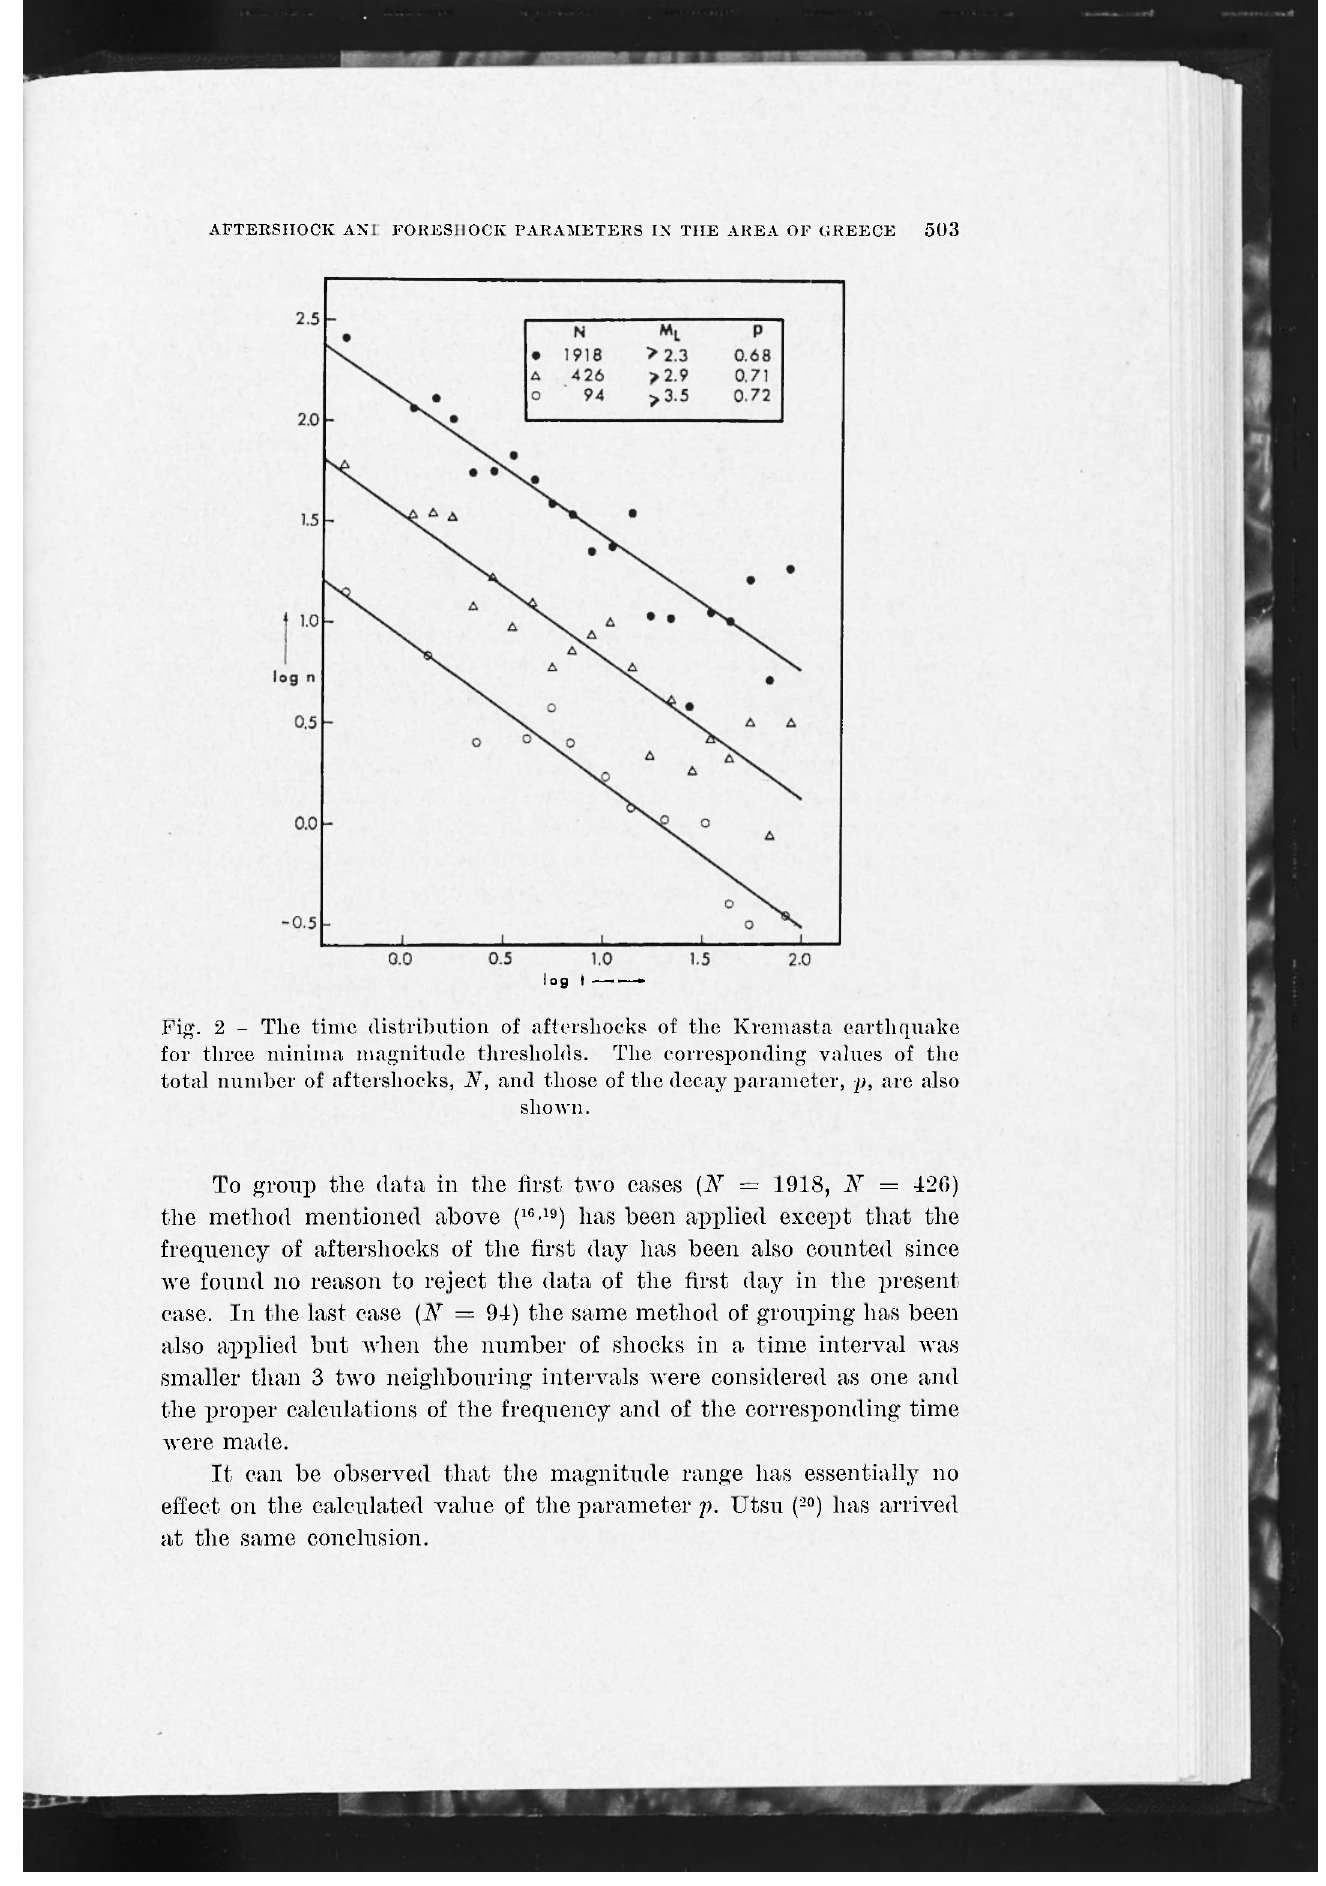
Fig. 2 - The time distribution of aftershocks of the Kremasta earthquake for three minima magnitude